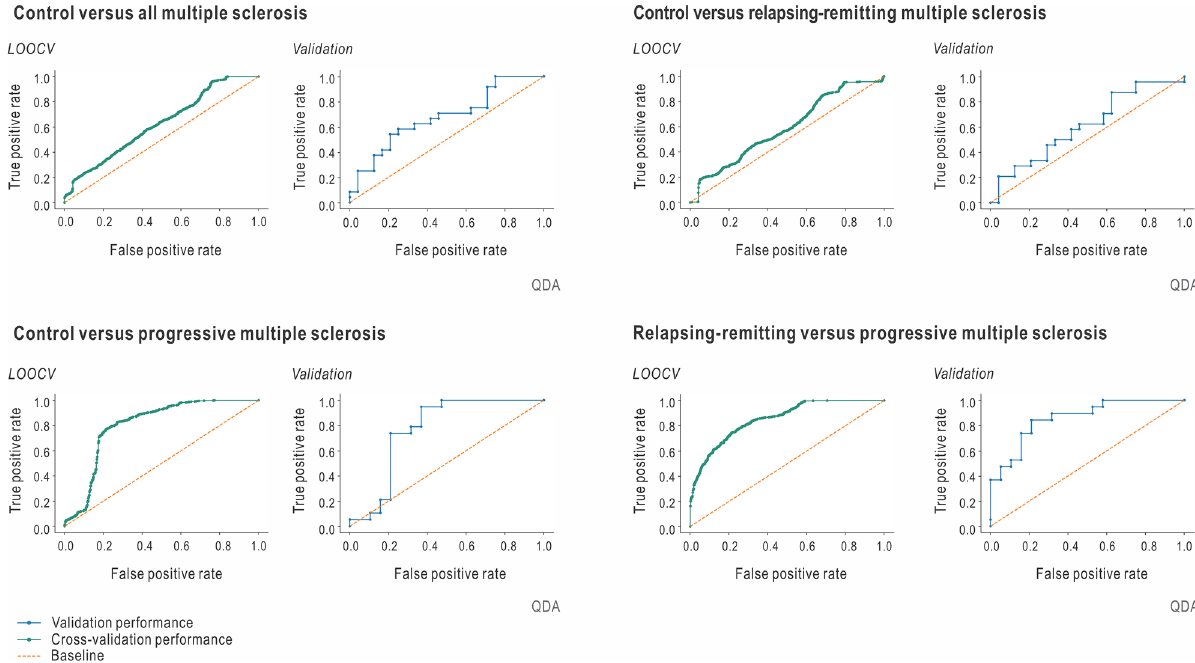
Figure 4. Receiver operating characteristic (ROC) curves for classification cross-validation and validation performance by question. Quadratic discriminant analysis (QDA) proved to be the top-performing classification algorithm by area under the receiver operating characteristic for all four questions. While it is visually clear that metabolite-based classifications between controls and multiple sclerosis patients, or between controls and relapsing–remitting multiple sclerosis patients, exhibited performance only marginally better than chance, ROC curves exhibited substantially increased convexity for questions involving the classification of progressive multiple sclerosis patients specifically, also reflected in higher sensitivity and specificities as shown in Fig. 3. Multiple sclerosis groups defined as positives in all plots; for the relapsing–remitting versus progressive question a positive is defined as relapsing–remitting multiple sclerosis. LOOCV: leave-one-out